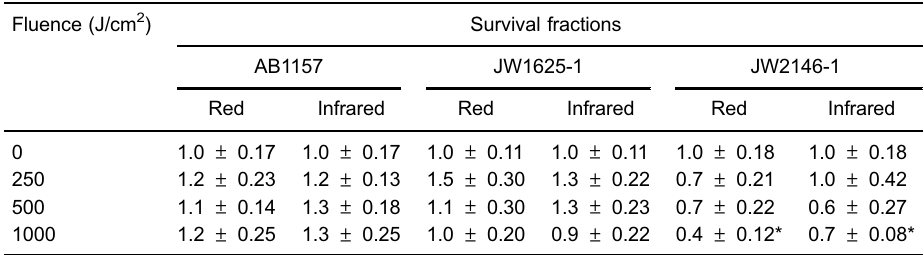
Table 2. Survival fractions of E. coli cultures exposed to low-intensity red and infrared lasers in exponential growth phase.